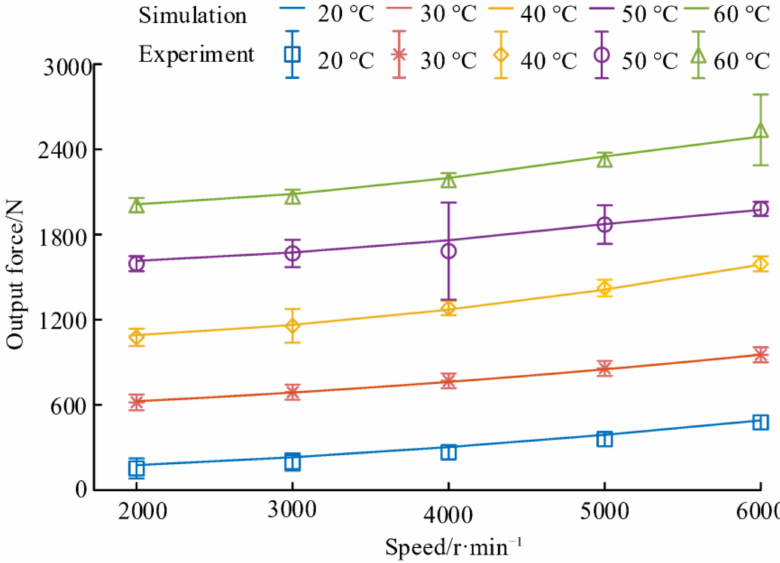
Figure 16. Effect of speed and temperature on the output force of the NPR